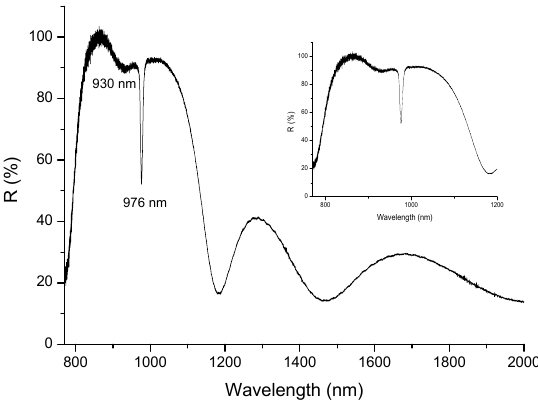
Figure 12. Reflectance of an active disk composed of a BM, an Yb-doped layer (36.3 micron thick) and an ARC coating, deposited on silicon.